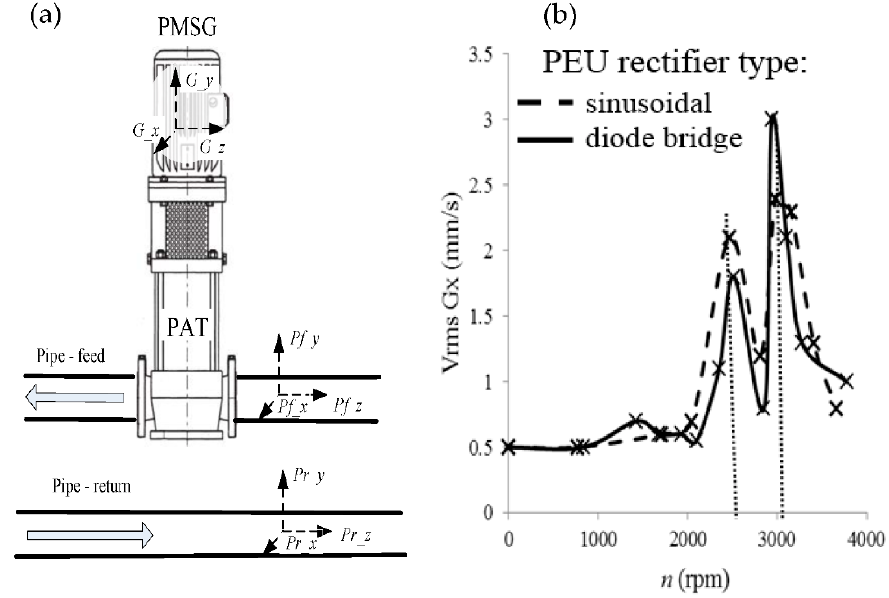
Figure 14. Vibration analysis: ( a ) location of measurement points; and ( b ) RMS-vibration velocity in speed domain for two types of PEU rectifier.